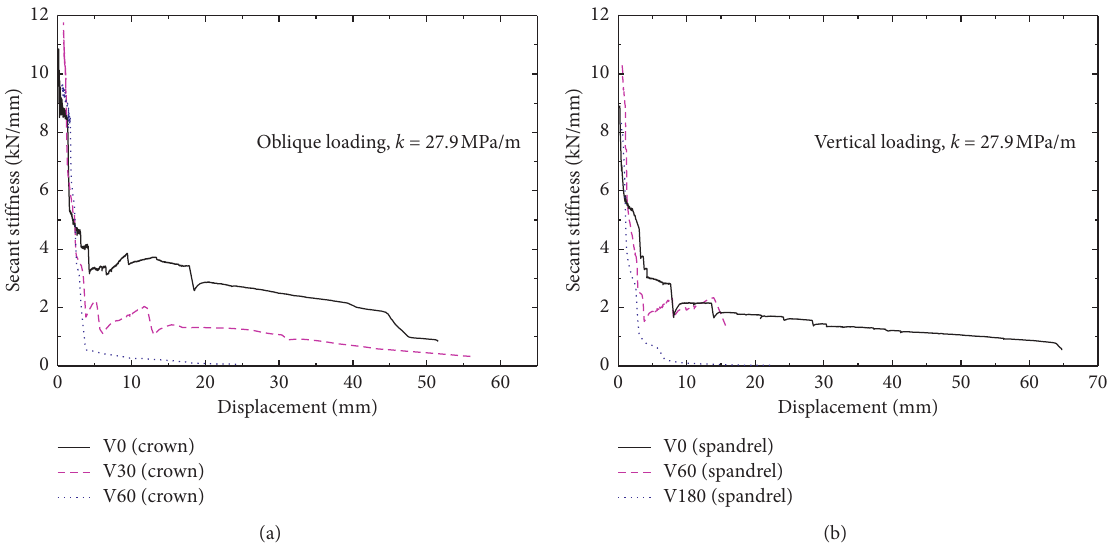
Figure 9: Secant stiffness-displacement curves of the lining with void defects: (a) crown and (b) spandrel.